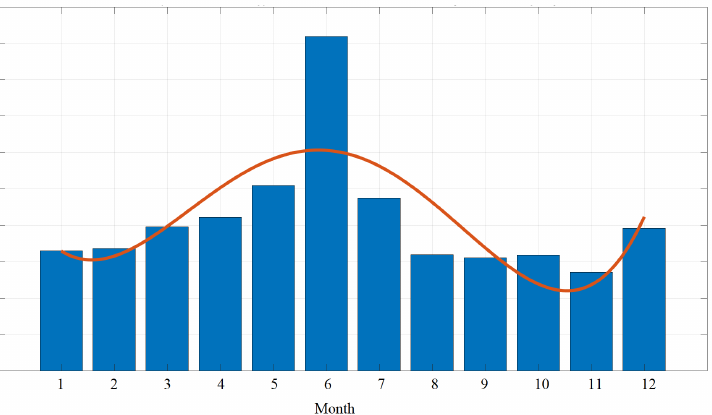
Figure 5. Empirical values and the approximation function of the seasonal variability of MV fail- ure